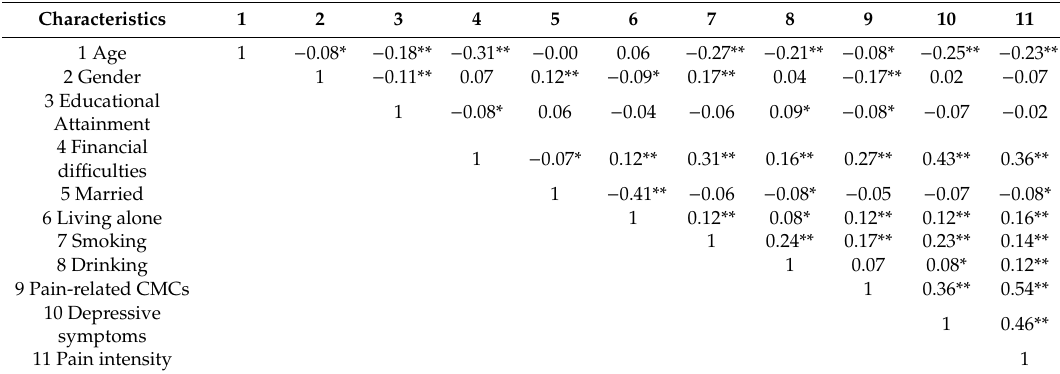
Table 2. Bivariate correlations.